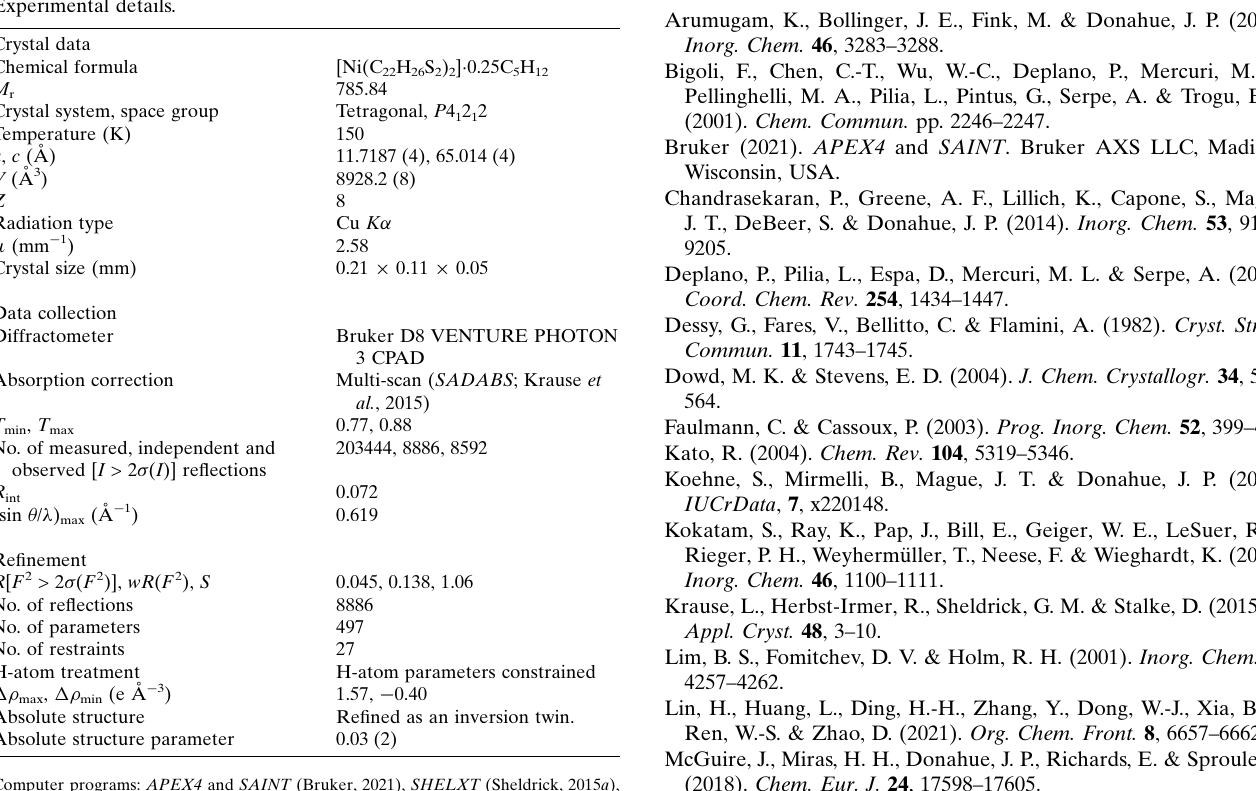
54:46 and 52:48 optimal partitioning, respectively, for the two groups. Hydrogen atoms were added in calculated positions